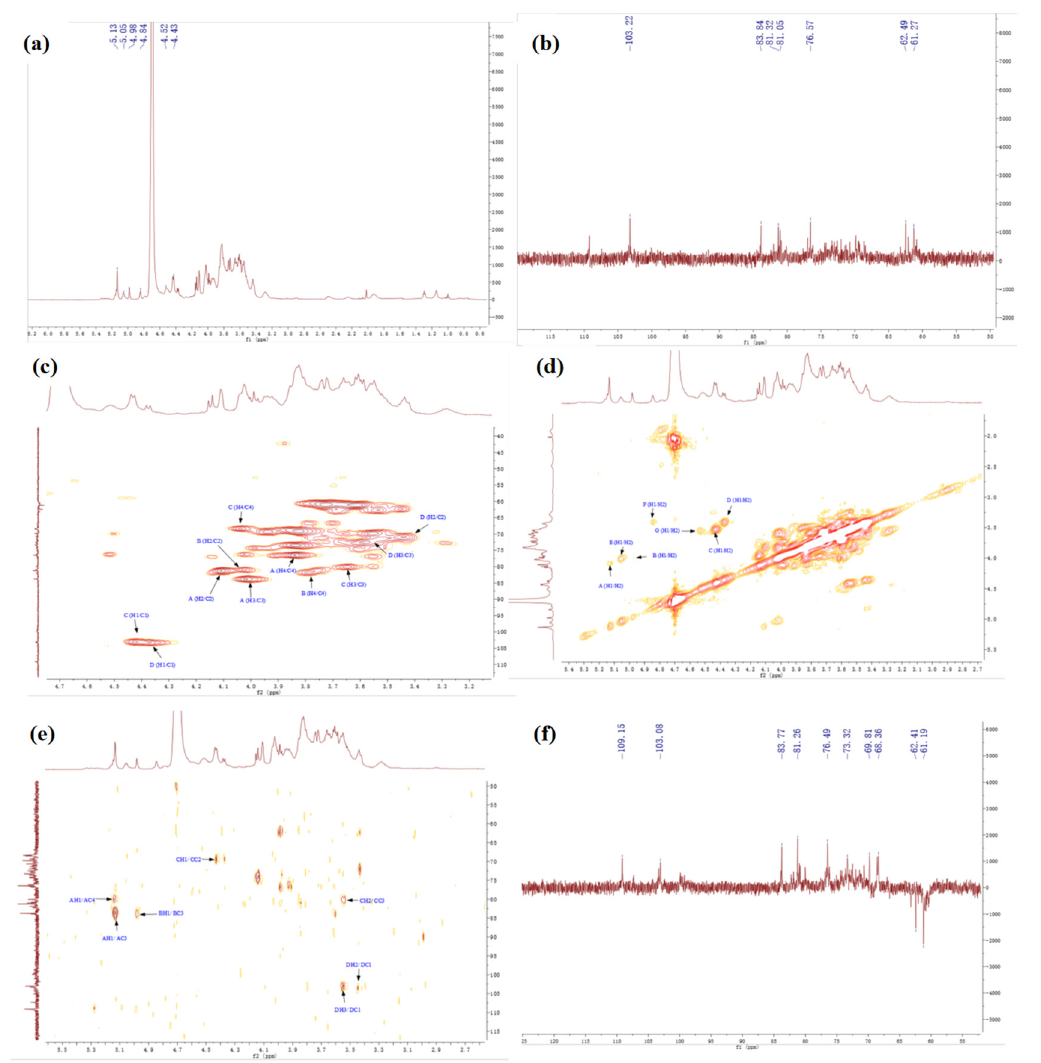
Figure 4. The NMR spectrum of SSP1. ( a ) 1 H, ( b ) 13 C, ( c ) HSQC, ( d ) COSY, ( e ) HMBC, ( f ) DEPT.